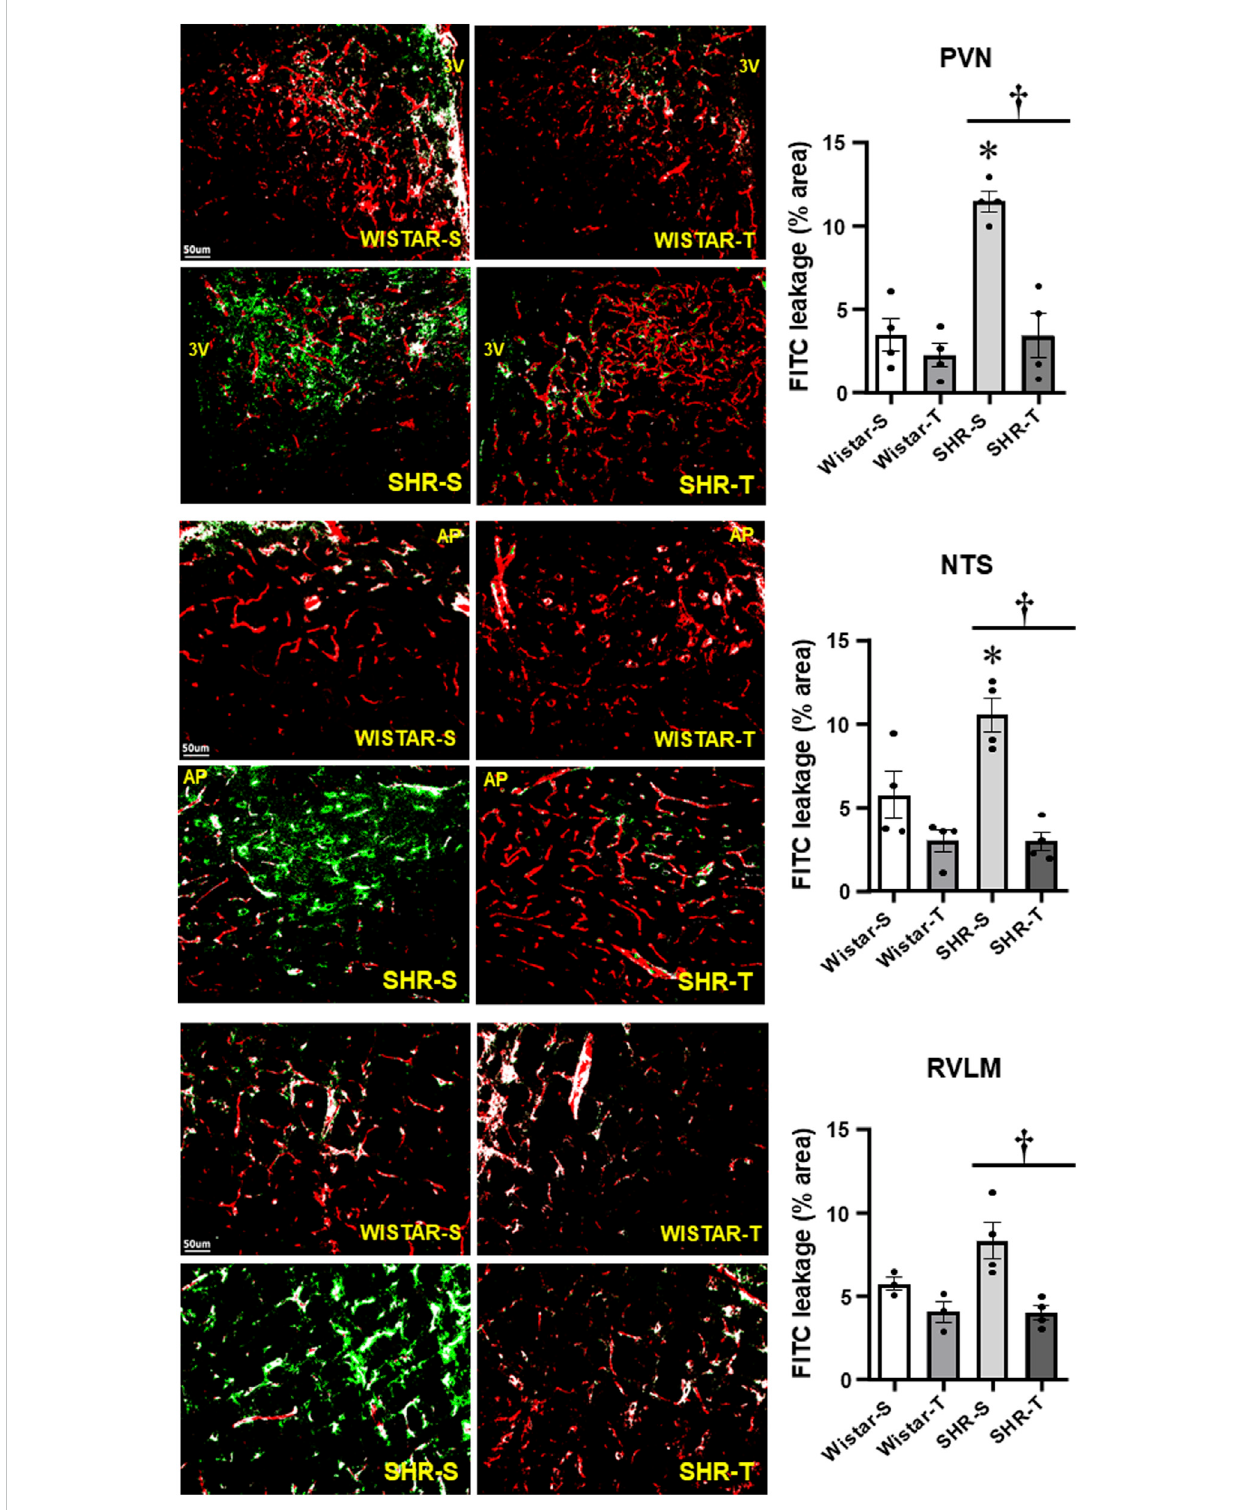
FIGURE 1 Comparison of BBB permeability within the PVN, NTS, and RVLM of sedentary (S) and trained (T) SHR and Wistar rats. Left photomicrographs show thecapillarynetwork(Rhodamine-70kDa,red),theFITC-10kDaleakage(green)intothebrainparenchymaandthecolocalizationofbothinsidecapillaries (white)withinthethreeautonomicareas.Scalebars=50 μ m.RightbargraphsdepicttheeffectsofhypertensionandexercisetrainingontheBBBleakage into the PVN, NTS and RVLM. Values are means of 5-7 slices/area/rat, 3-4 rats/group. Comparisons made by 2-way factorial ANOVA. PVN: group F (1,12)=23.57,p < 0.001,conditionF(1,12)=23.98,p < 0.001,groupxconditionF(1,12)=13.06,p=0.004;NTS:groupF(1,12)=5.96,p=0.031,condition F(1,12)=28.53,p < 0.001,groupxconditionF(1,12)=6.27,p=0.028;RVLM:groupF(1,10)=3.40,p=0.090,conditionF(1,10)=19.79,p < 0.001,groupx condition F (1,10) = 3.85, p = 0.073. Signi fi cances (p < 0.05) are * vs. respective Wistar group; † vs. respective S